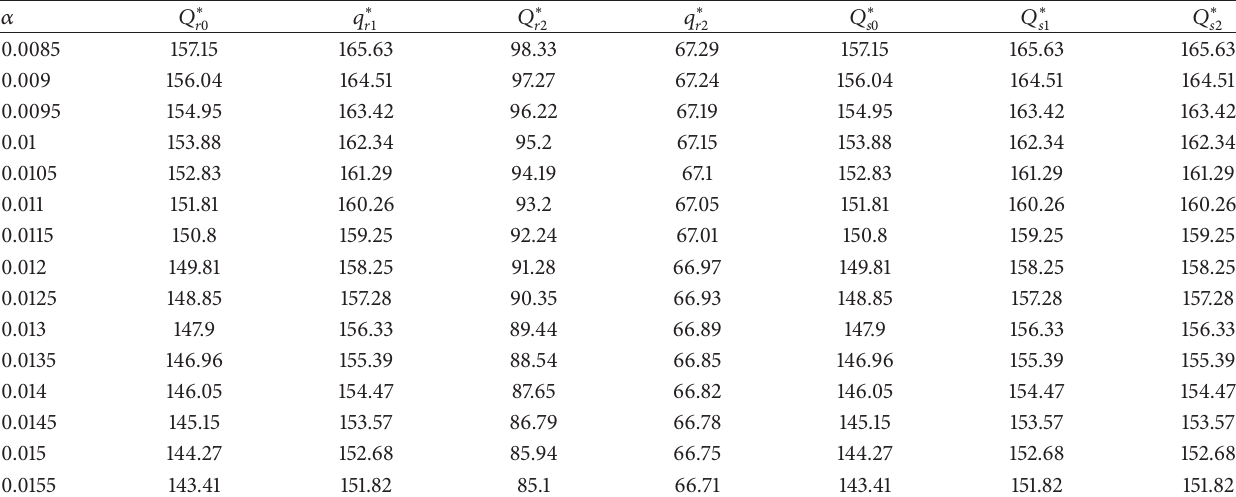
Table 4: The impact of 𝛼 on the optimal decisions.